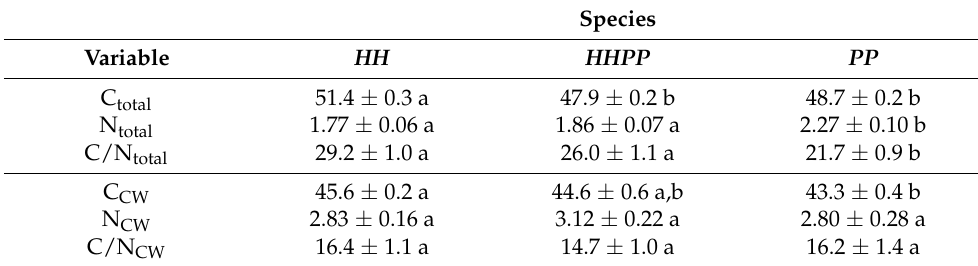
Table 3. Mean values (±SE) of total and cell wall (CW) carbon, nitrogen, and carbon/nitrogen ratio in leaves of the three Oesporangium species. Units of C total and N total are g/100g of dry weight (DW), whereas C CW and N CW are in g/100g of alcohol insoluble residue (AIR). Different letters indicate